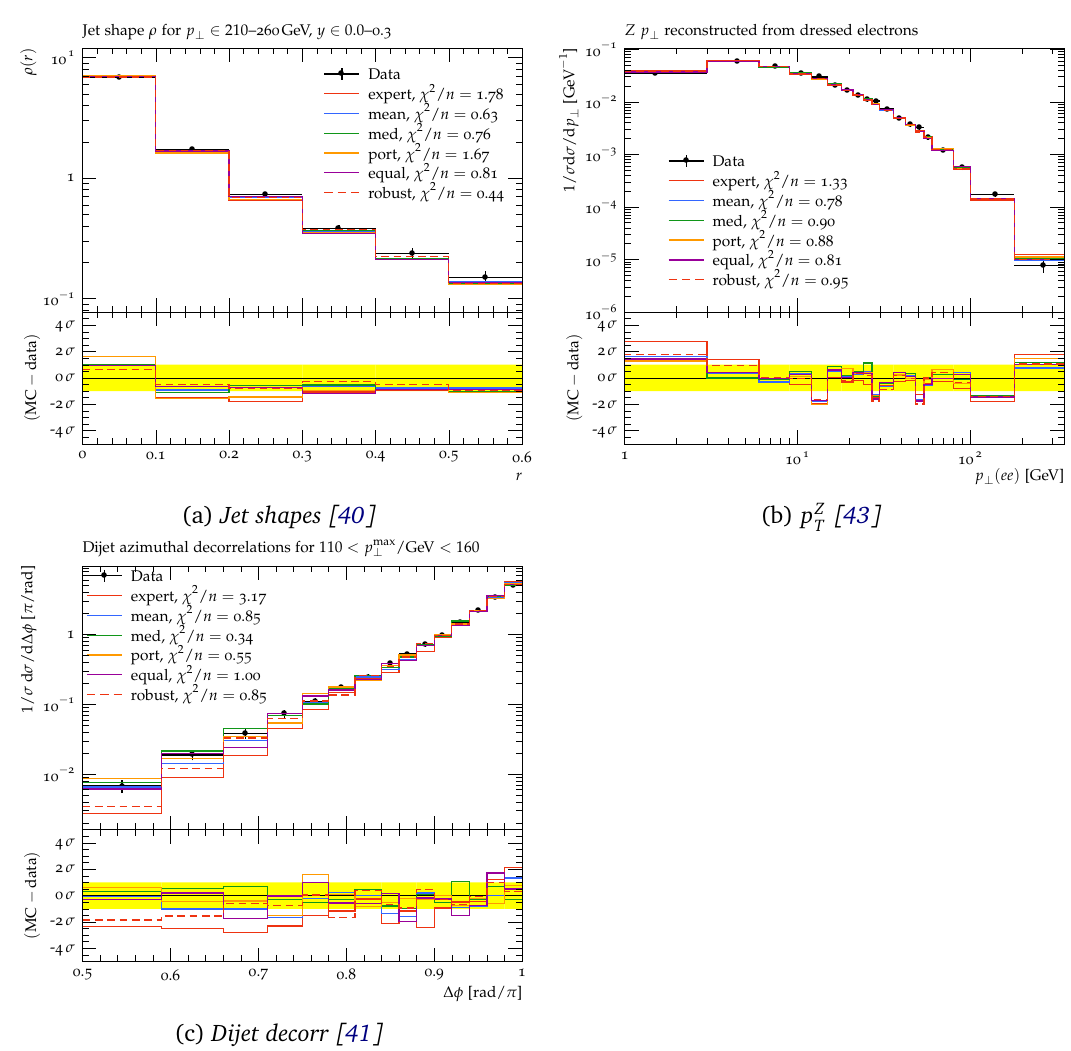
Figure 8: Examples of A14 observables and their χ 2 tuning leads to better fits than the expert’s hand